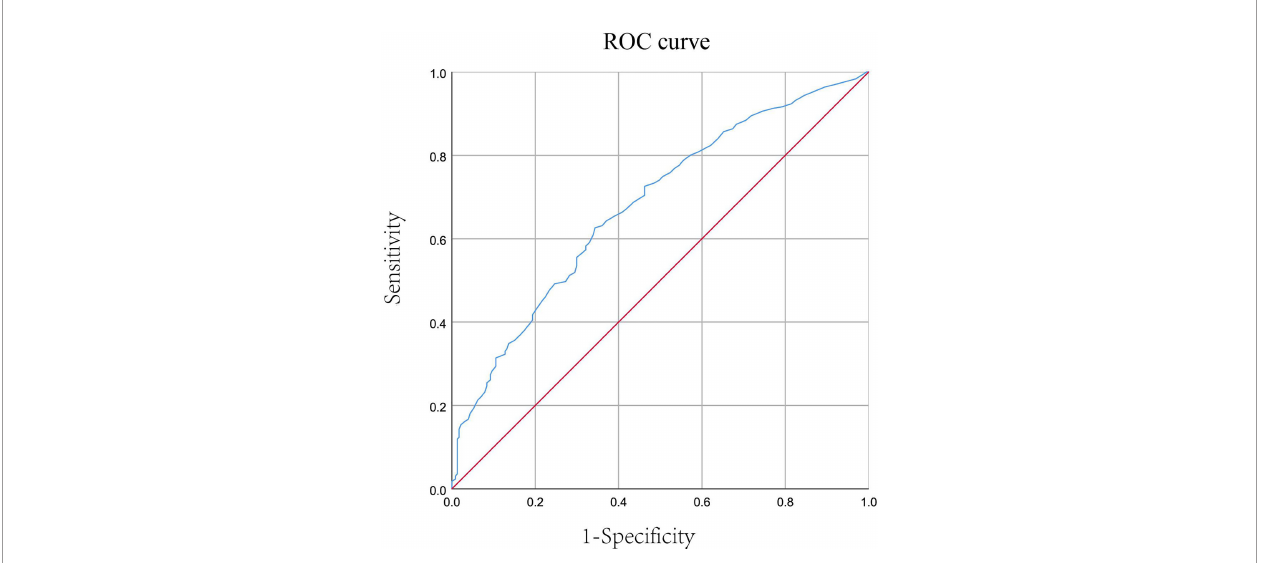
FIGURE 2 | Receiver operating characteristics curve of the predictive utility of AMH for TE among women with DOR (area under the curve (AUC) = 0.679, 95% CI: 0.639-0.72, P <